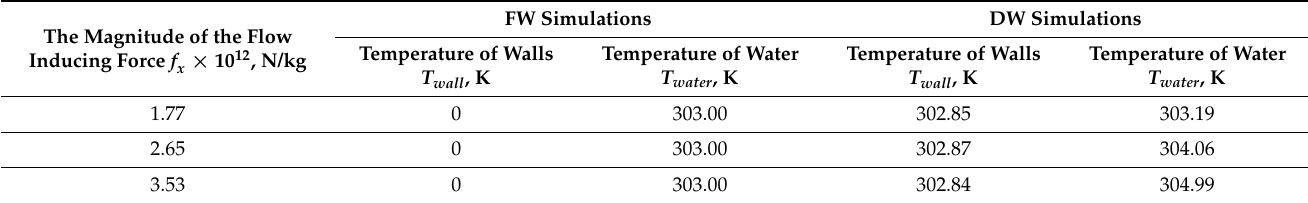
Table 2. Simulation average temperatures for FW and DW simulations with different magnitudes of flow inducing force f x . The Magnitude of the Flow Inducing Force f x × 10 12 , N/kg